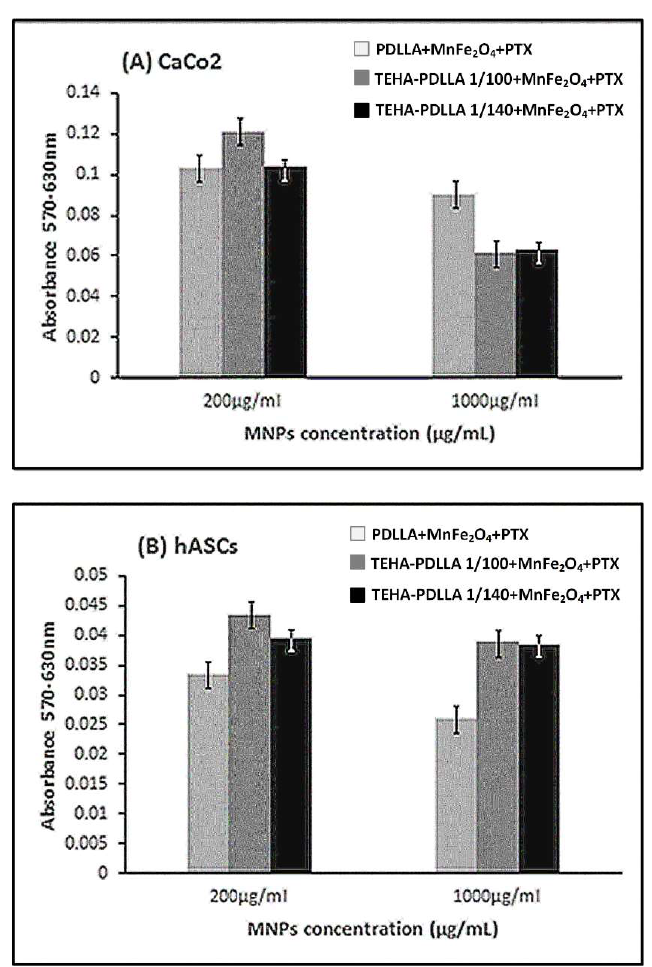
Figure 10. PXT dissolution profiles for the prepared magnetic core–shell polymeric nanoparticles.